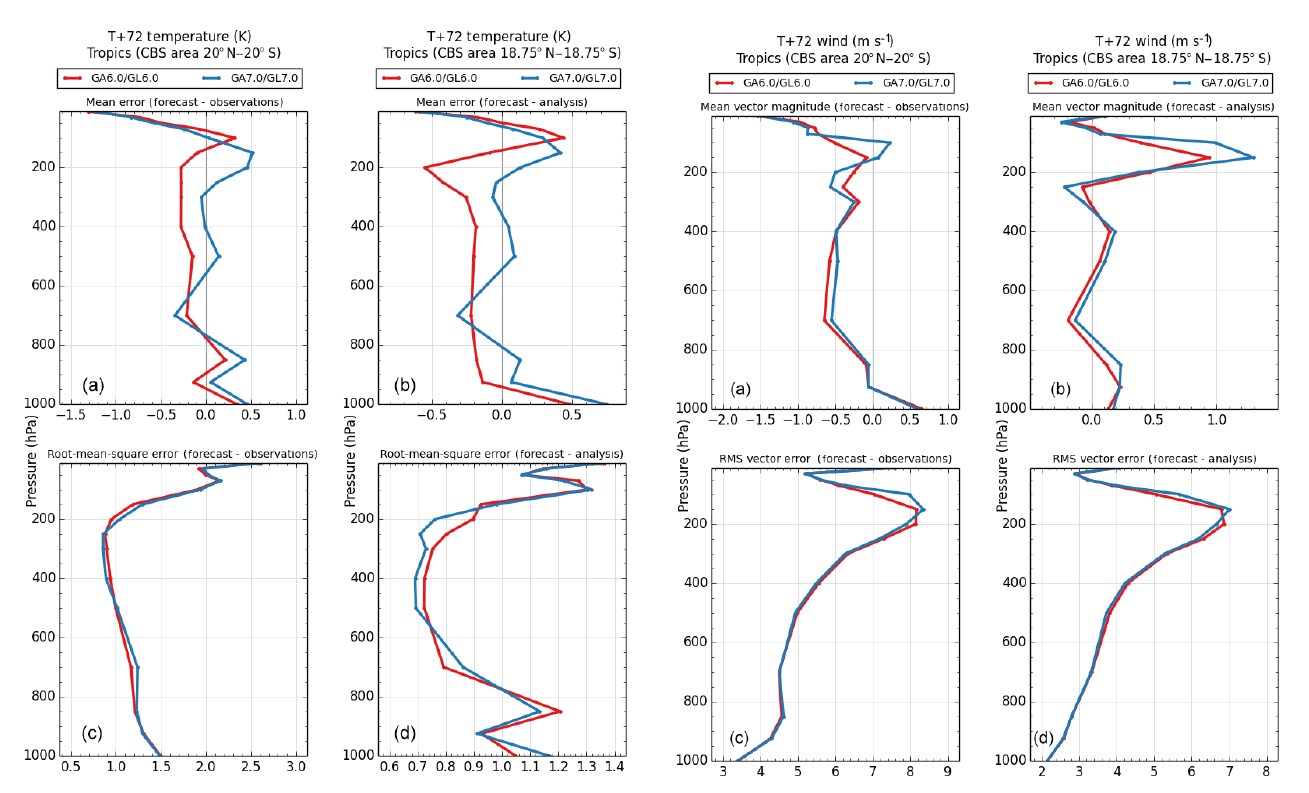
Figure 23. Profiles of 3-day (T + 72) tropical wind speed bias (a, b) and vector wind RMSE (c, d) versus radiosonde observations (left) and ECMWF analyses (right) from the N768 GA6.0 and GA7.0 case studies presented in Fig.